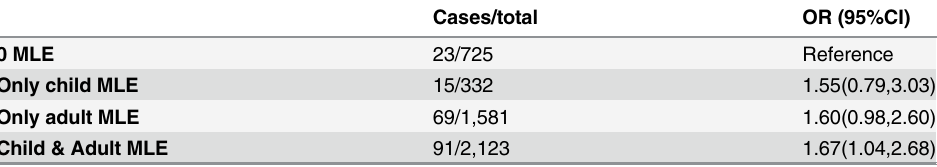
Table 3. The joint association of child and adult (both work and private life) MLE and risk of type 2 DM. Odds ratios (OR)( ± 95% confidence intervals) (CI) are adjusted for age, sex, family history of diabetes and